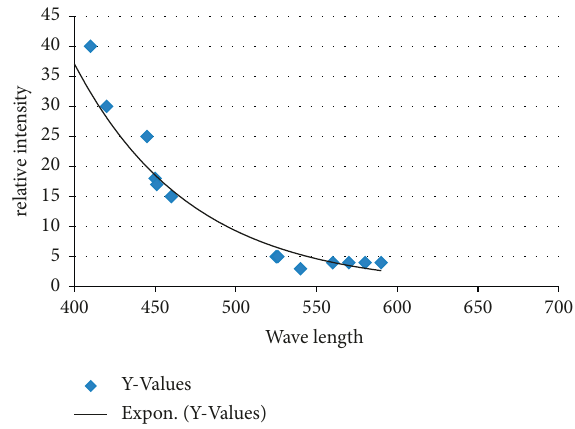
Figure 6: When the silver nanoparticles and water were placed at the same angle, this picture shows the difference in intensity be- tween them [5].